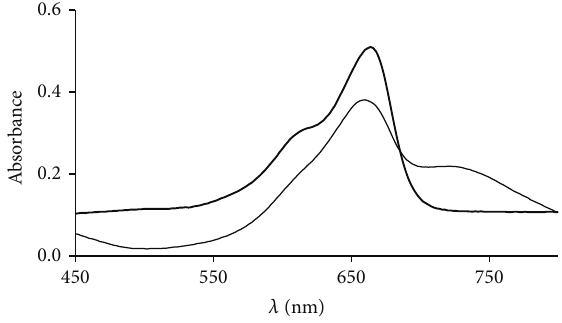
Figure 3: UV-Vis spectra of methylene blue during oxidation by H 2 O 2 in the presence of Ni (thick) and Ni/Al 2 O 3 (thin).